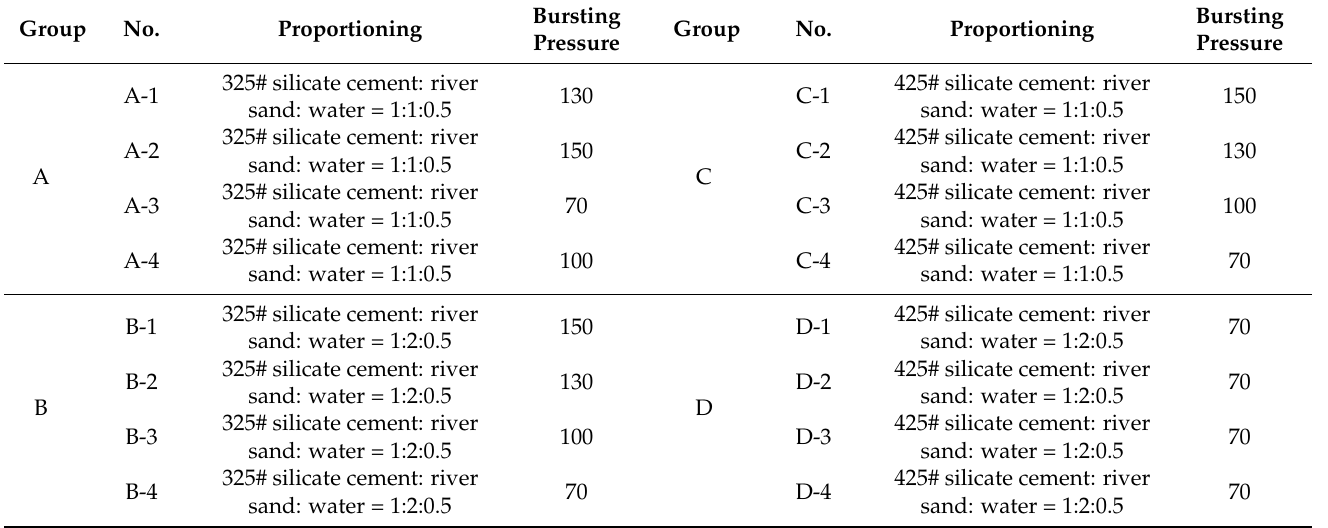
Figure 1. Concrete test block shell hole layout. Table 1. Types of test blocks. Table 1. Types of test blocks.